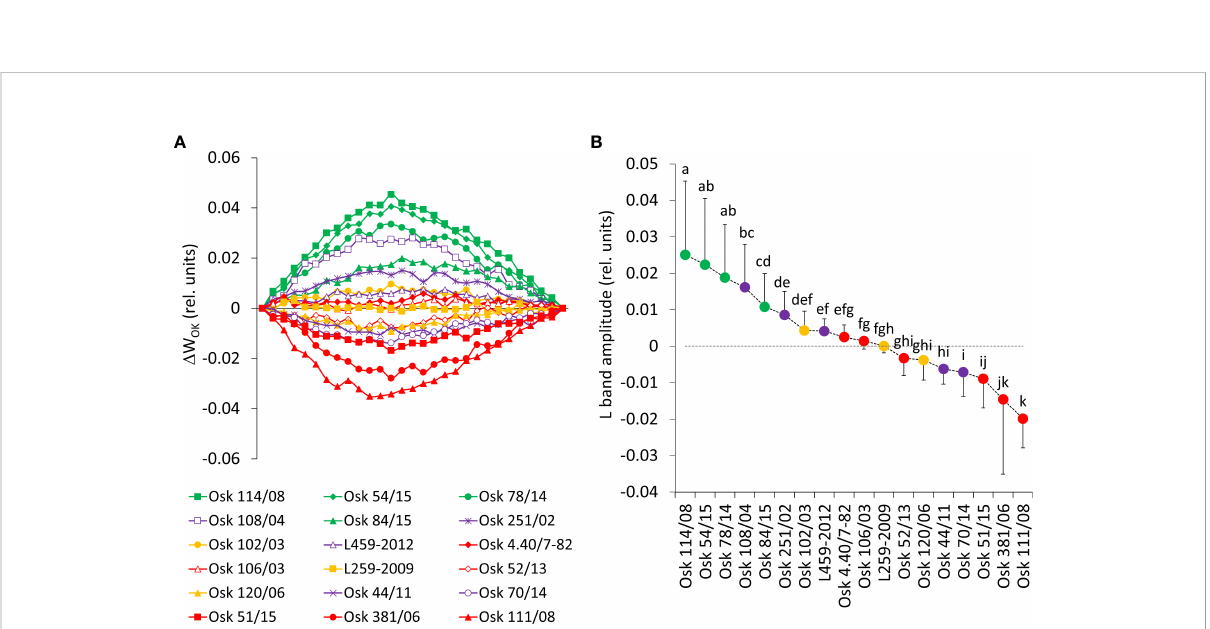
FIGURE 7 (A) Differential curves of relative variable fl uorescence O-K normalized induction curves for 18 wheat genotypes as W OK = (F t -F o )/(F K -F o ), each line averages 20 measurements. For the analysis of different kinetics and to reveal the band (L-band) that is typically hidden between steps O and K, the divergences between the relative variable fl uorescence curves of the stress treatment (PEG induced water de fi cit, Y = -0.33 MPa) and control ( fi eld conditions, water potential Y = -0.03 MPa) were calculated as D W OK = W Treatment – W Control . (B) Mean values of L-band divergences (dispersion refers to maximal values or the amplitude) and statistical differences among genotypes (one-way ANOVA F 17,522 = 87.7, p< 0.0001, means followed by a common letter are not signi fi cantly different by the Tukey HSD-test at the 5% level of signi fi